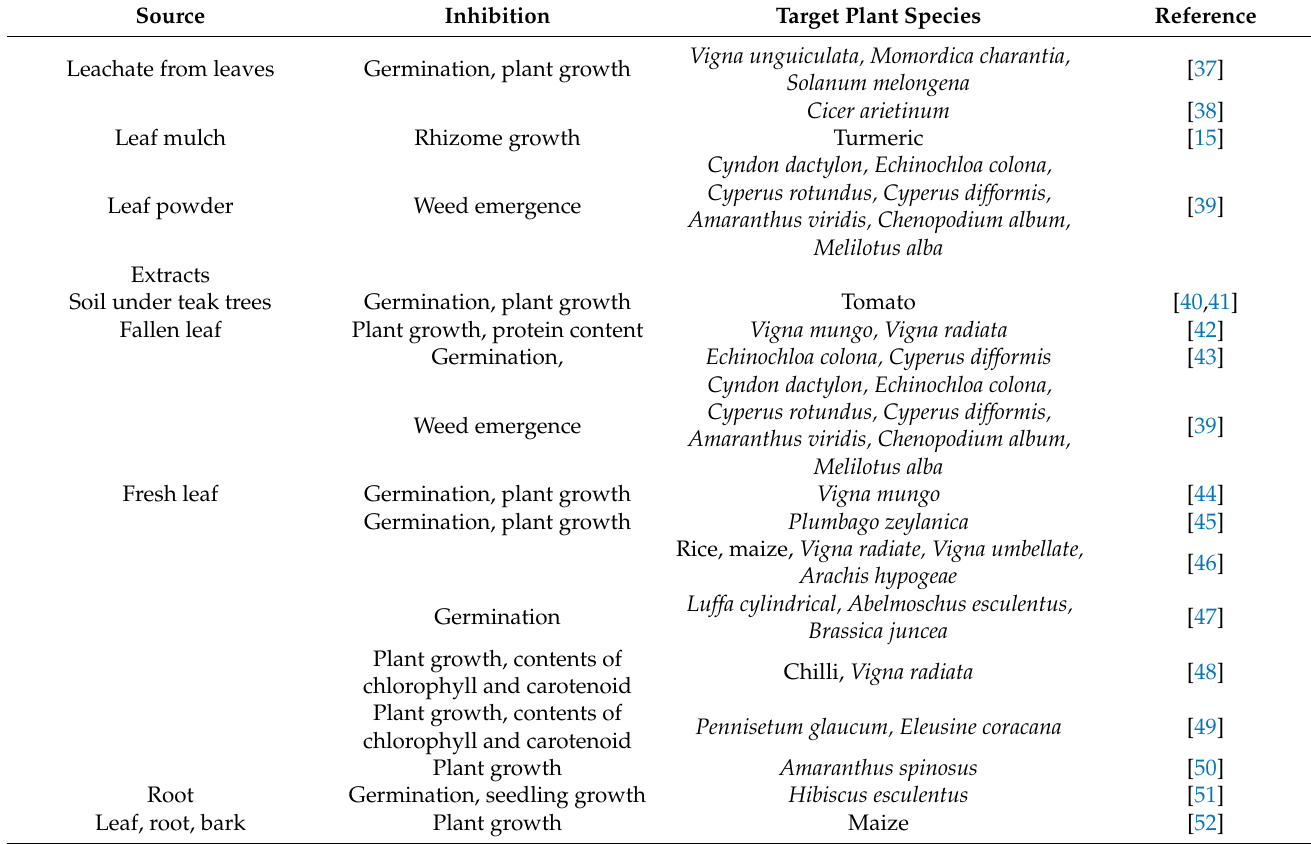
Table 1. Allelopathic activity of the leachate, leaves and extracts of teak and target plant